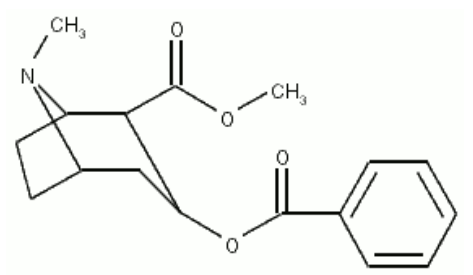
Figure 1. Chemical structure of